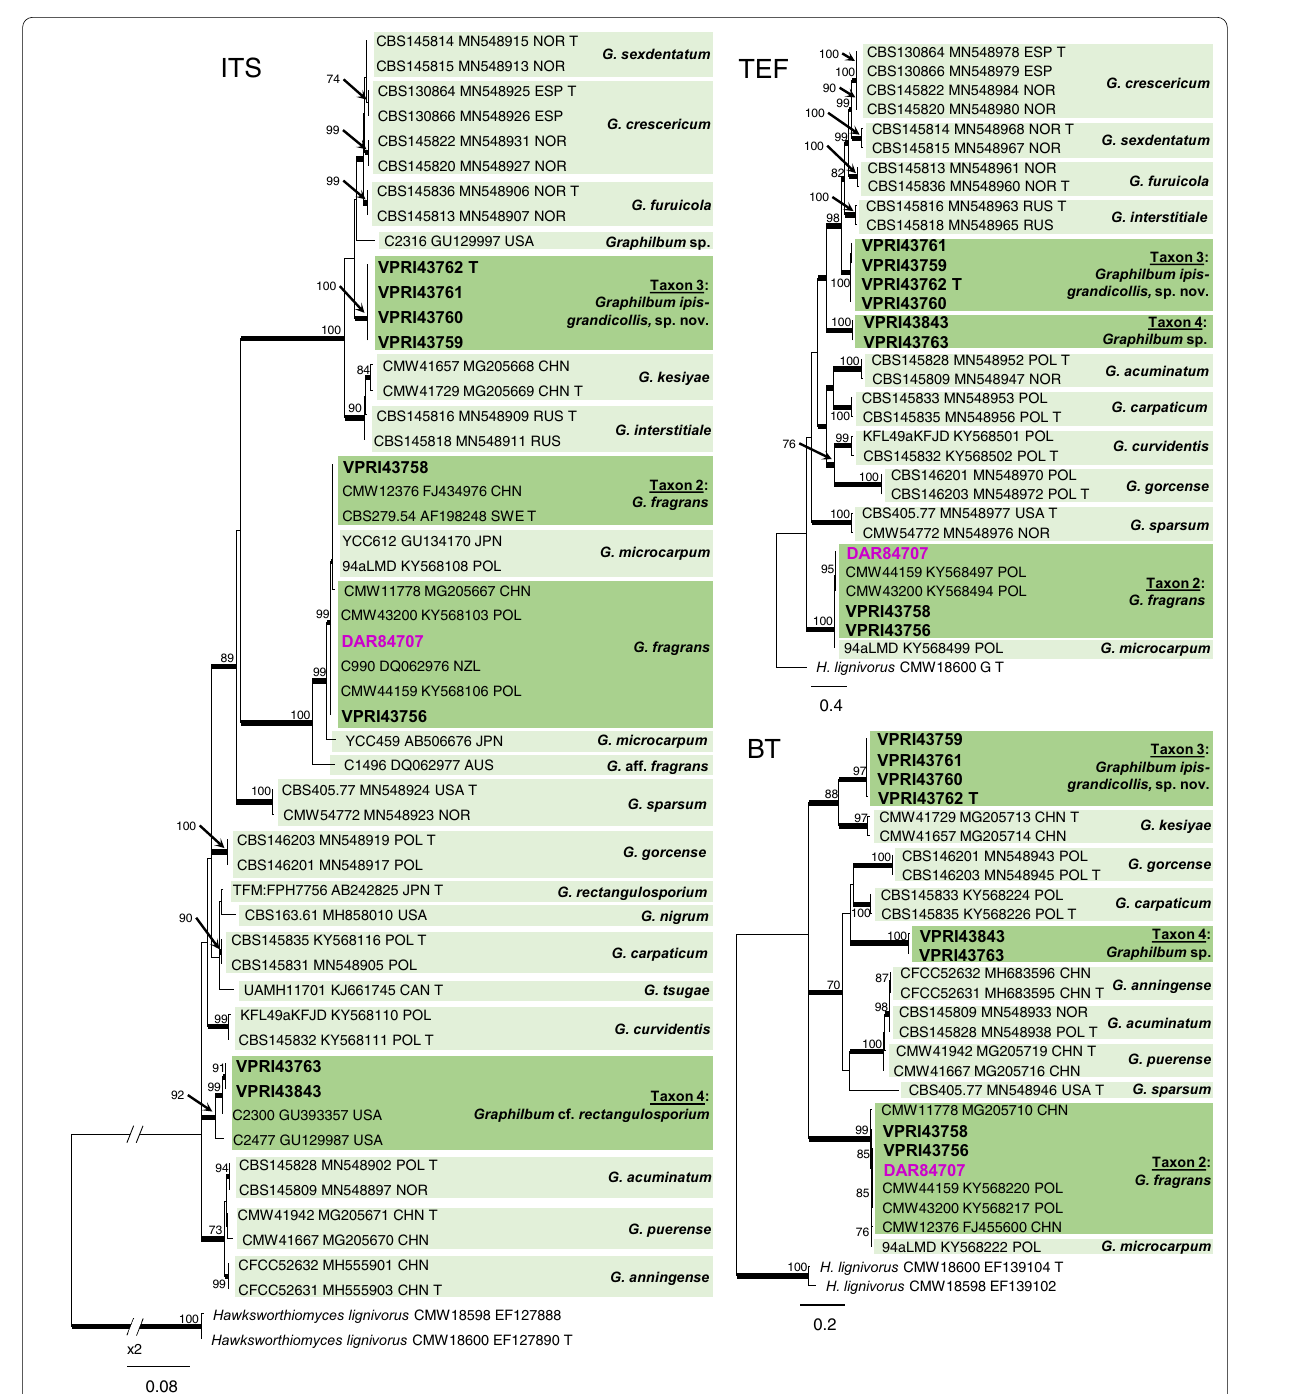
Fig. 4 Phylogenetic analysis of isolates residing in Graphilbum. Sequences generated in this study are printed in bold with reference collection isolates coloured purple. Bold branches indicate posterior probability values T ex-type cultures, G sequence retrieved from = =